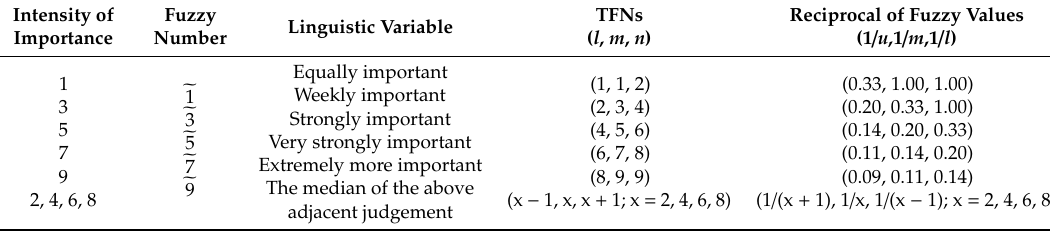
Table 3. Scale for the relative importance of variables used in the pairwise fuzzy comparison matrix